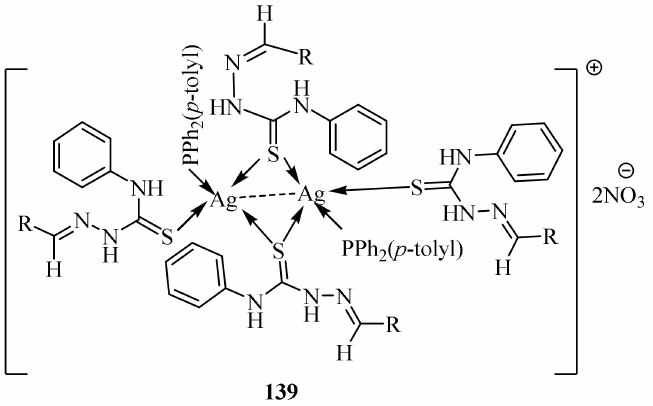
Figure 4. Structures of the silver complexes 139